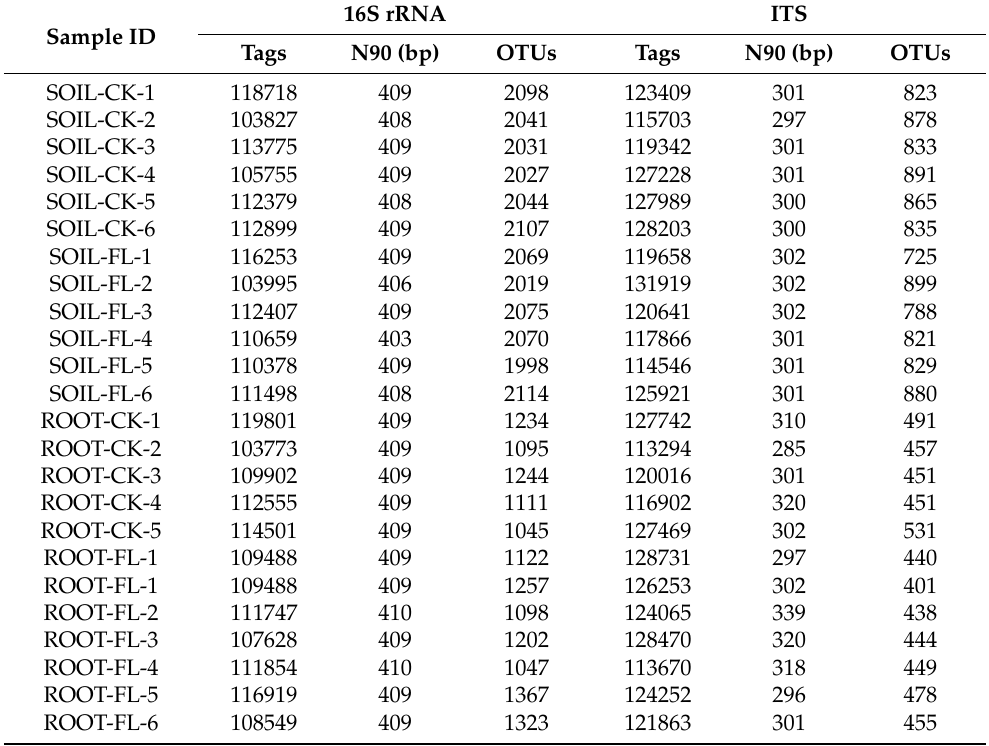
Table 1. Statistics of the metabarcoding sequencing data for soil and root samples. FL stands for Fenlong-ridging, and CK stands for conventional